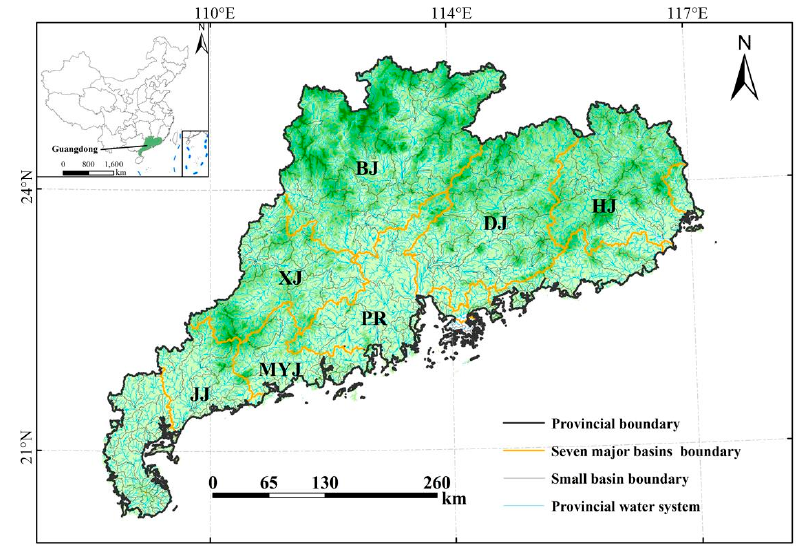
Figure 1. Basins in Guangdong. BJ: Beijiang basin, DJ: Dongjiang basin, HJ: Hanjiang basin, XJ: Xijiang basin, PR: Pearl River basin, MYJ: Moyangjiang basin, JJ: Jianjiang river basin.